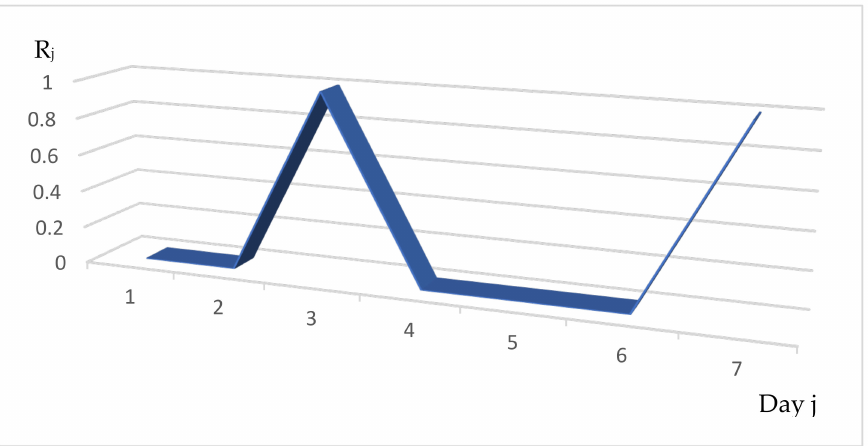
Figure A5. Values of the daily reproduction numbers R j along the period of contagiousness of length 7